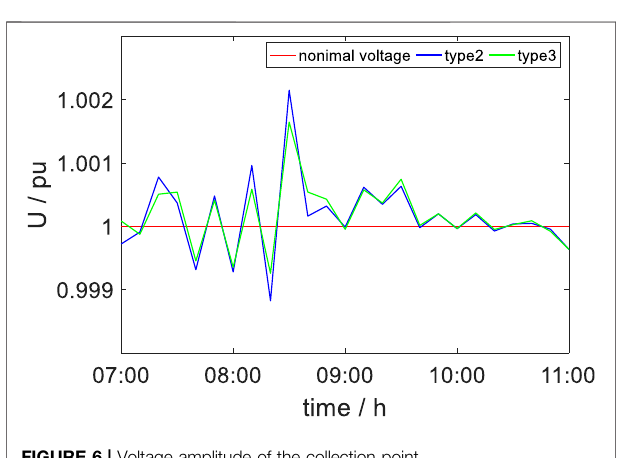
FIGURE 6 | Voltage amplitude of the collection point.